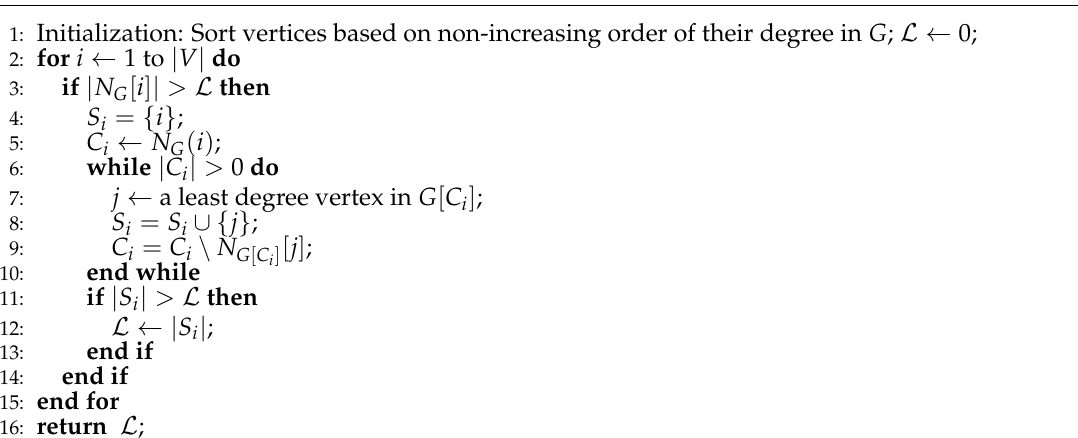
Algorithm 1 Greedy induced star construction